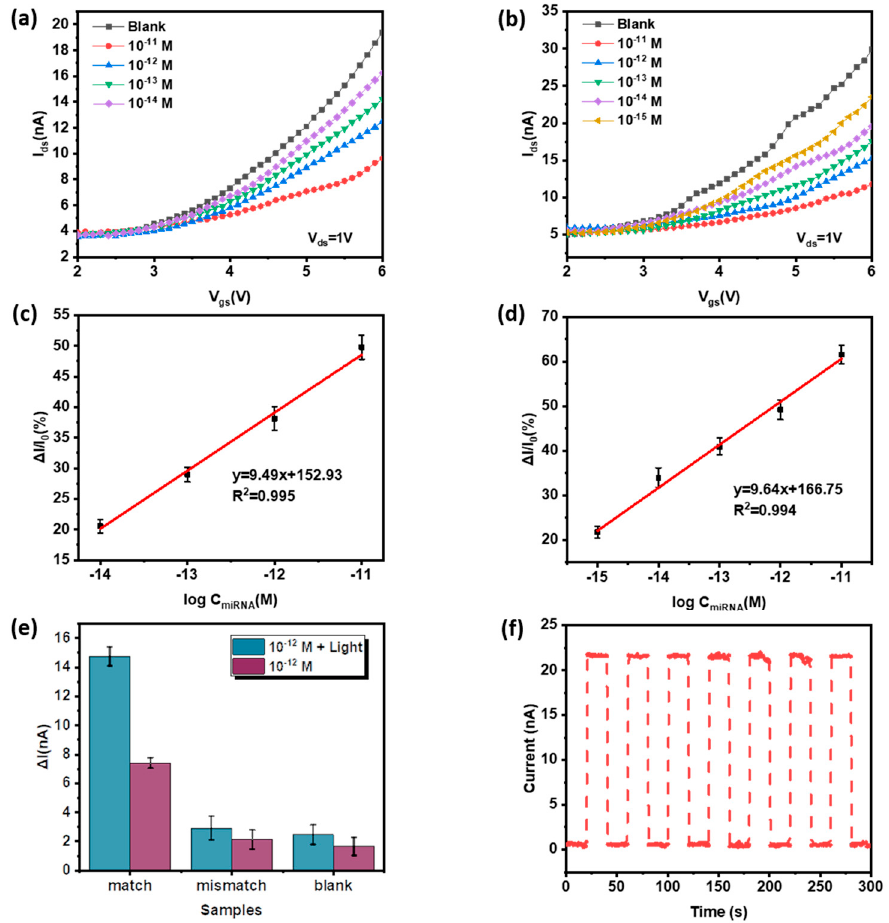
Figure 8. ( a ) Transfer curve current response of Blank (MC-Au-Probe) and target miRAN-155 added with 10 − 11 M, 10 − 12 M, 10 − 13 M, 10 − 14 M in PBS (pH 7.4, 0.01 M) solution without external light, and corresponding calibration curve ( c ); ( b ) Under the condition of 405 nm blue-violet light, in PBS (pH 7.4, 0.01 M) solution, Blank (MC-Au-Probe) and 10 − 11 M, 10 − 12 M, 10 − 13 M, 10 − 14 M, 10 − 15 M target miRAN-155 transfer curve current response, and the corresponding calibration curve ( d ); ( e ) 10 − 12 M target miRNA-155, single base mismatch miRNA-155 and blank control group’s current difference between the transfer curve and Blank (MC Au Probe) under the conditions of external light and no external light; ( f ) Repeatability experiment of the device in 300 s.